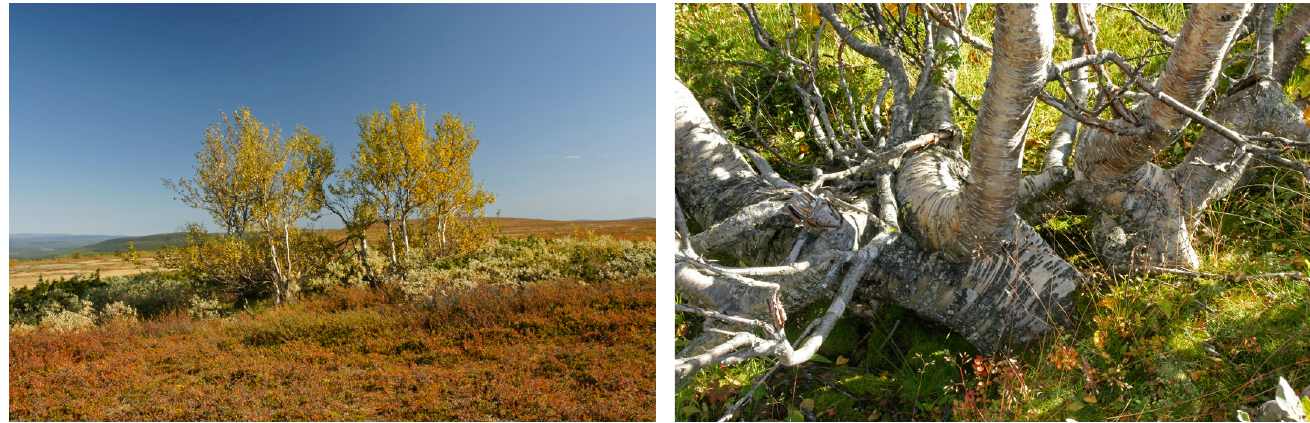
Figure 4: Left. A birch tree clone with no stems higher than 2 m in the early-20th century, when this site was above the local treeline. Right . Disproportionally stout lower trunks display 150-200 tree rings. Mt. Falkstolen, 925 m a.s.l. 14 September 2009.